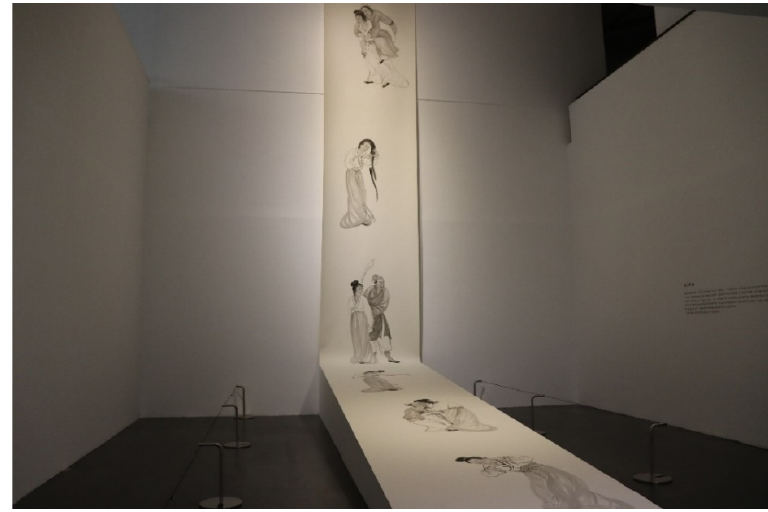
Figure 4. “Old Tales Retold” by Wei Peng, 160 × 5000 cm, ink on paper, 2019. Picture from the Center for Visual Studies, Peking University.